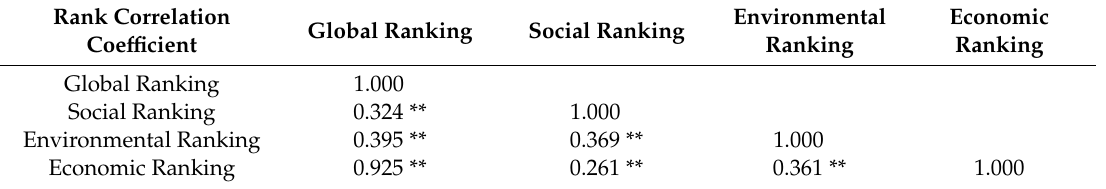
Table 6. Kendall tau test.